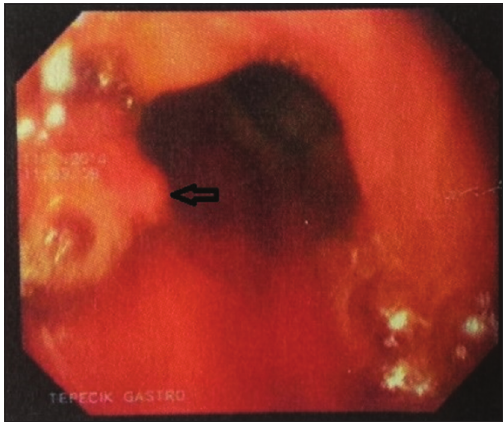
FIGURE 1. The endoscopic shape of the lesion shows a polypoid lesion with central ulceration (arrow).